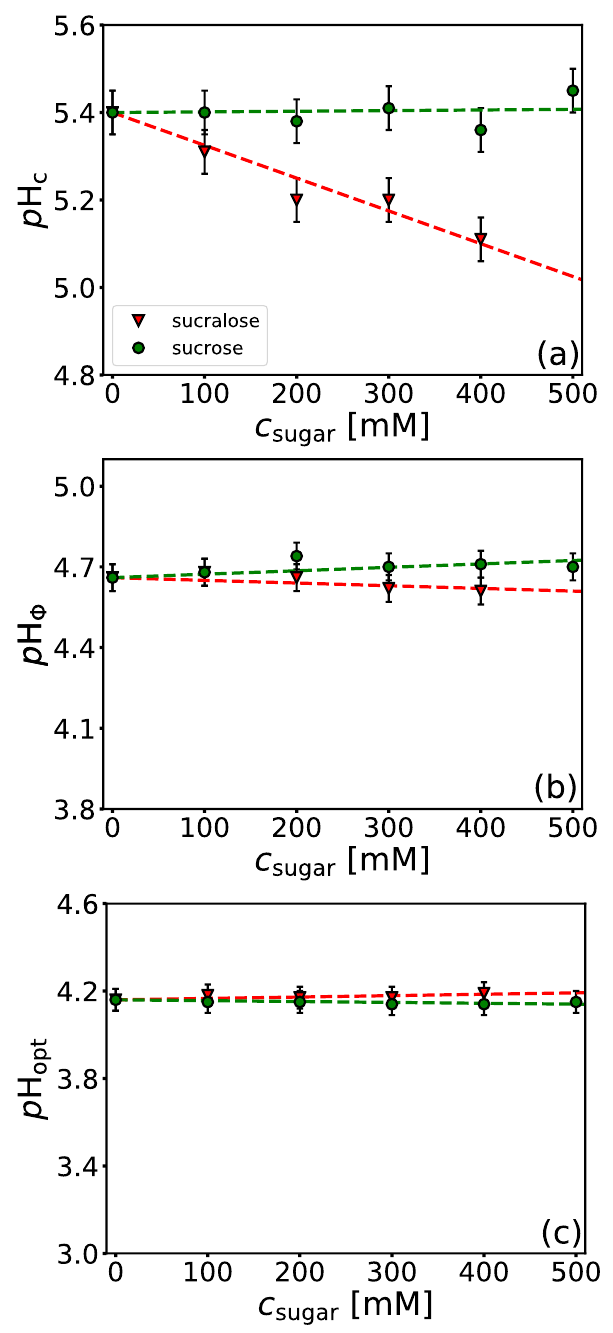
Figure 6. Sucralose hinders the formation of soluble protein-PE complexes. Same as in Figure 3, but for sucrose and sucralose: ( a ) p H c , ( b ) p H Φ , and ( c ) p H opt . Presented data speak in favour of the stabilizing role of sucralose in BSA/NaPSS solutions, especially at the onset of the formation of the soluble protein-PE complexes. At p H > p I BSA , the interactions between BSA and NaPSS are rather weak due to